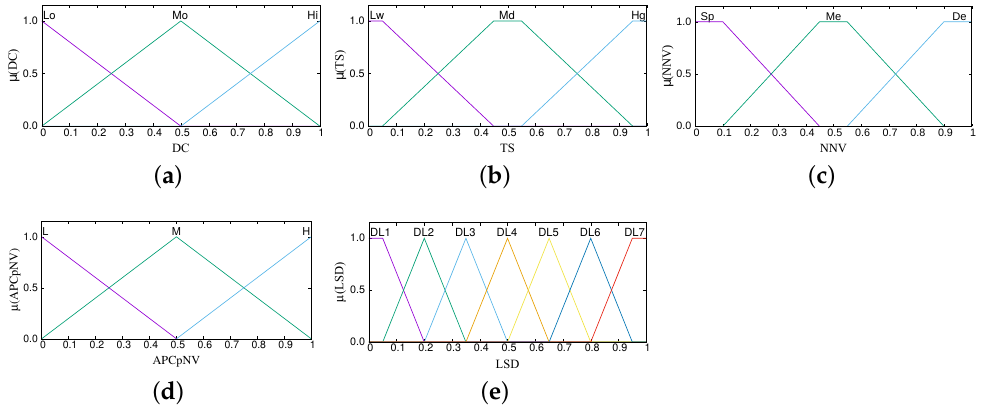
Figure 7. Membership functions of FS-CFELS. ( a ) Data Complexity, ( b ) Time Sensitivity, ( c ) Number of Neighboring Vehicles, ( d ) Avg. PC per Neighbor Vehicle, and ( e ) Layer Selection Decision.